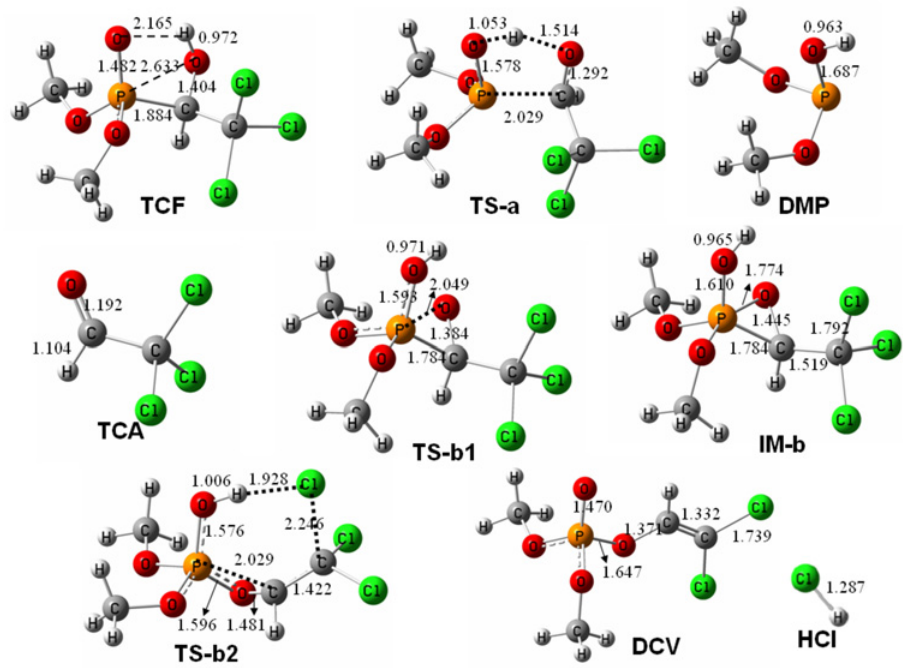
Fig 5. Optimized structures of the key species involved in the pyrolysis of trichlorfon at B3LYP/6-311 +G(d,p).